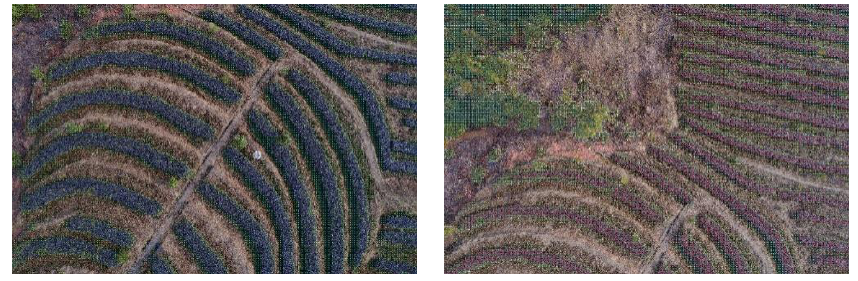
Figure 13. Mean shift clustering results of different image examples.